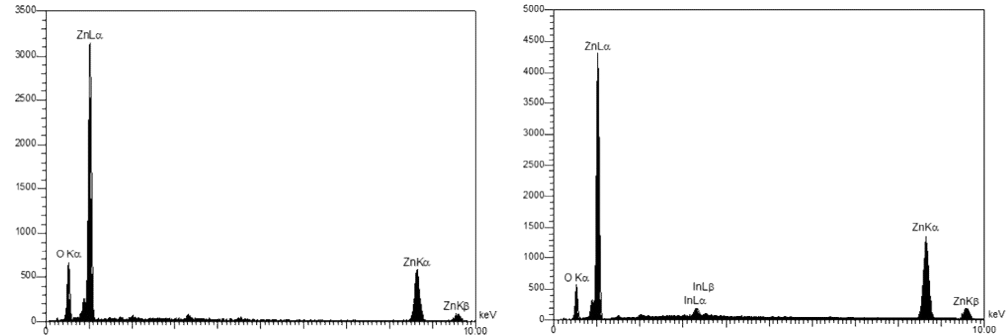
Fig. 2: EDX spectra of (a) pure ZnO (b) In doped ZnO nanoparticles.